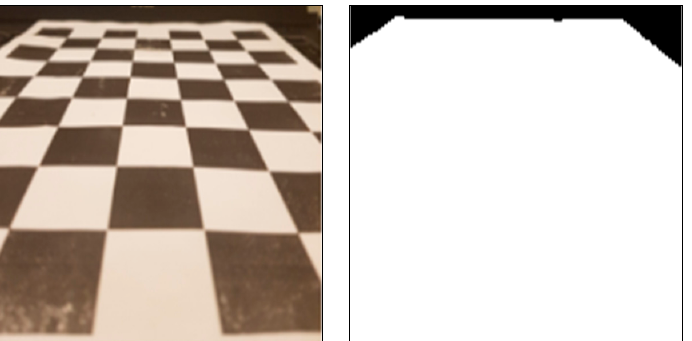
Figure 5. Result of semantic segmentation process.